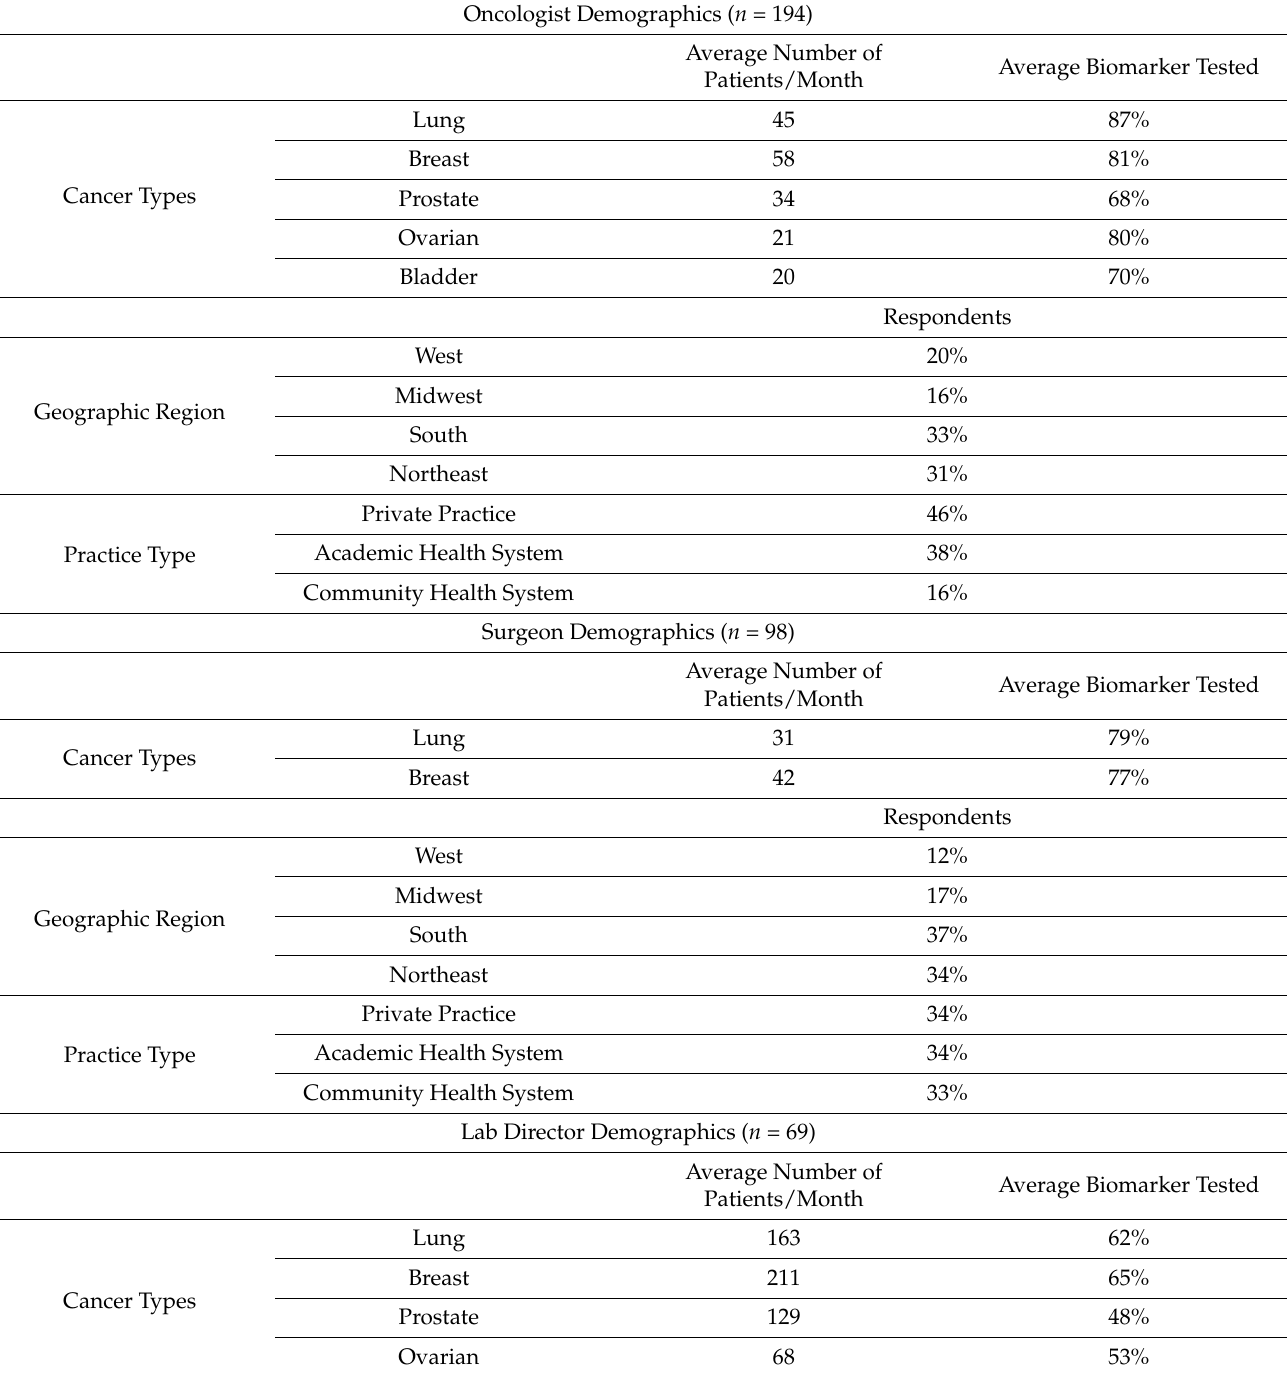
Table 1. Survey development was informed by 60-min phone interviews with at least one of each stakeholder surveyed, except patients. Table 1. Includes the demographics of all survey respondents delineated by stakeholder types. Stakeholders for this study include medical oncologists, surgeons, lab directors, payers, and cancer patients. Oncologists and surgeons are sometimes reported together and referred to as “clinicians” throughout the